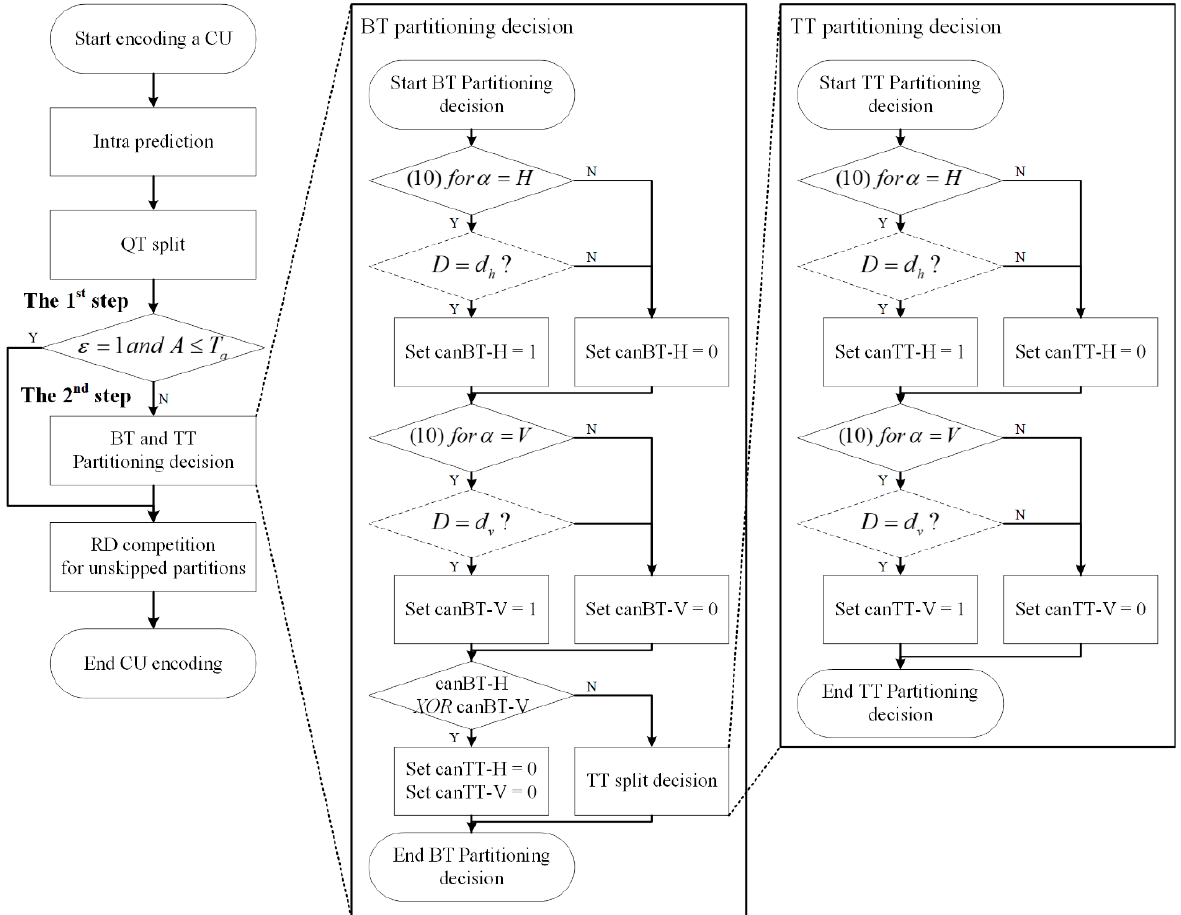
Figure 8. Flowchart of proposed fast partitioning decision method.